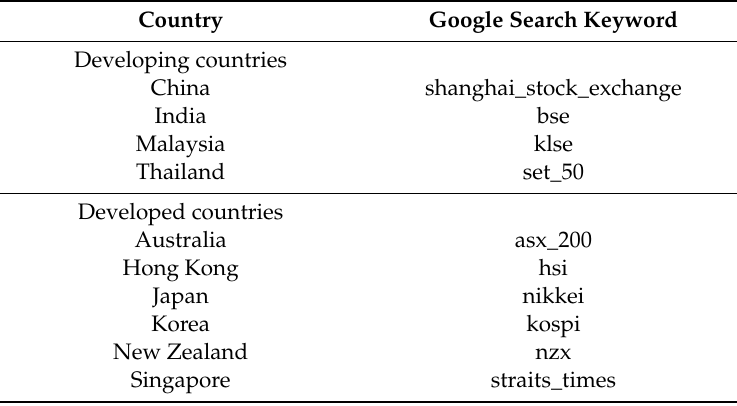
Table A1. Google search keywords for stock market